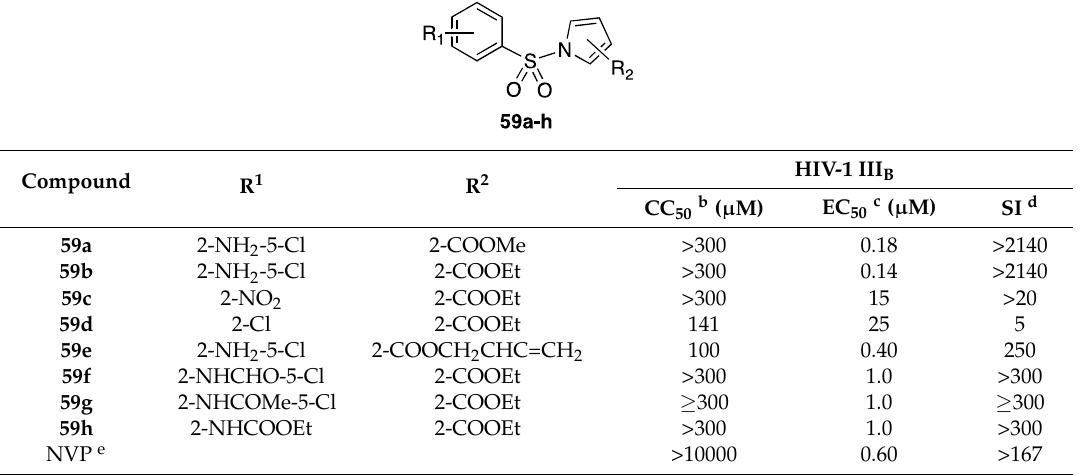
Table 5. Anti-HIV-1 activity of amino-PAS 59a – h against the WT strain a .